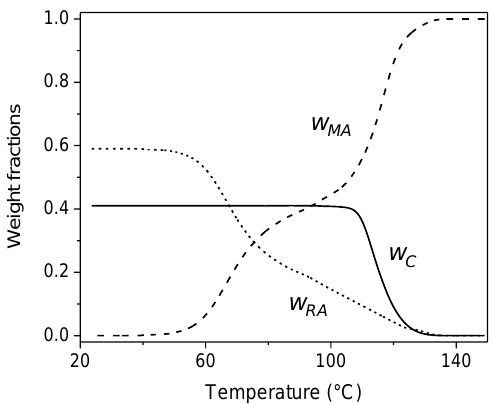
Figure 20. Temperature evolution of the mobile amorphous ( w MA : dashed line), crystalline ( w C : solid line), and rigid amorphous ( w RA : dotted line) weight fractions during non-isothermal crystallization of PLLA at 2 K min −1 . Estimated errors: ±0.02 for w C and w MA , ±0.04 for w RA . (Reprinted (adapted) with permission from [79]. Copyright (2017) Springer).